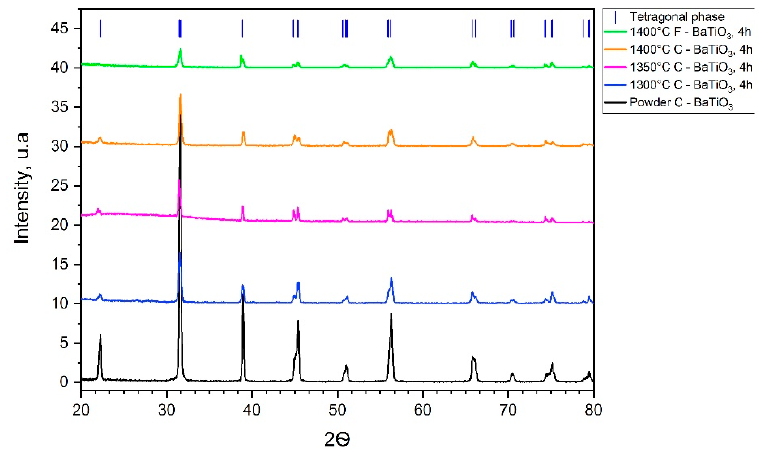
Figure 11. XRD of a sample sintered at different temperatures.